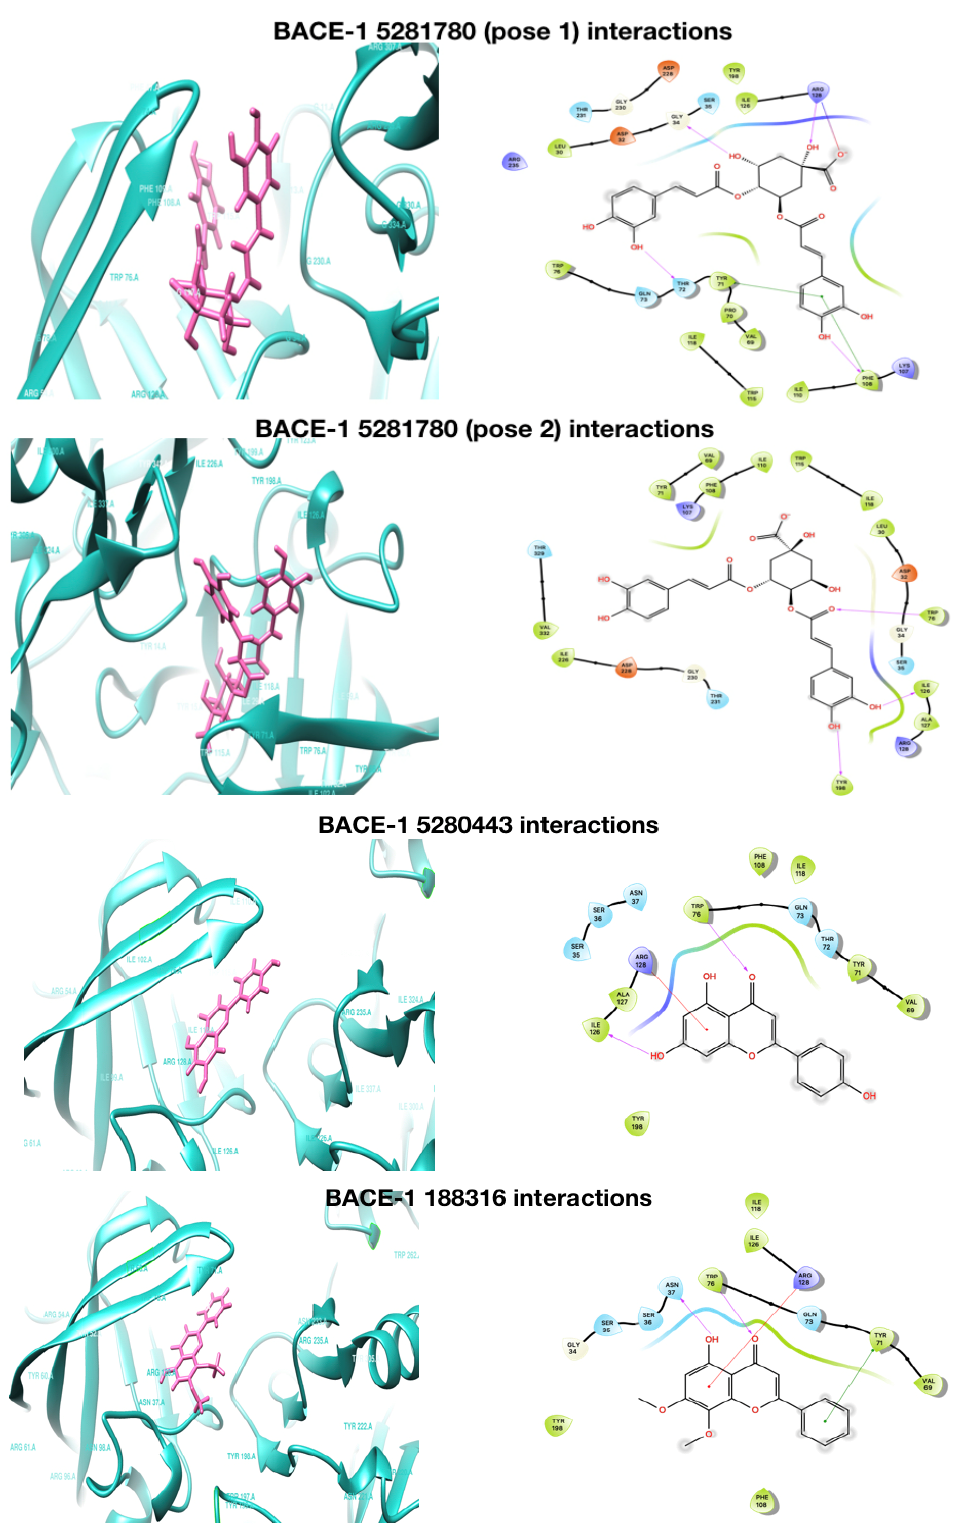
Figure 3. Molecular docking interaction of BACE-1 with 5281780 (pose 1, pose2), 5280443 , and 188316 .